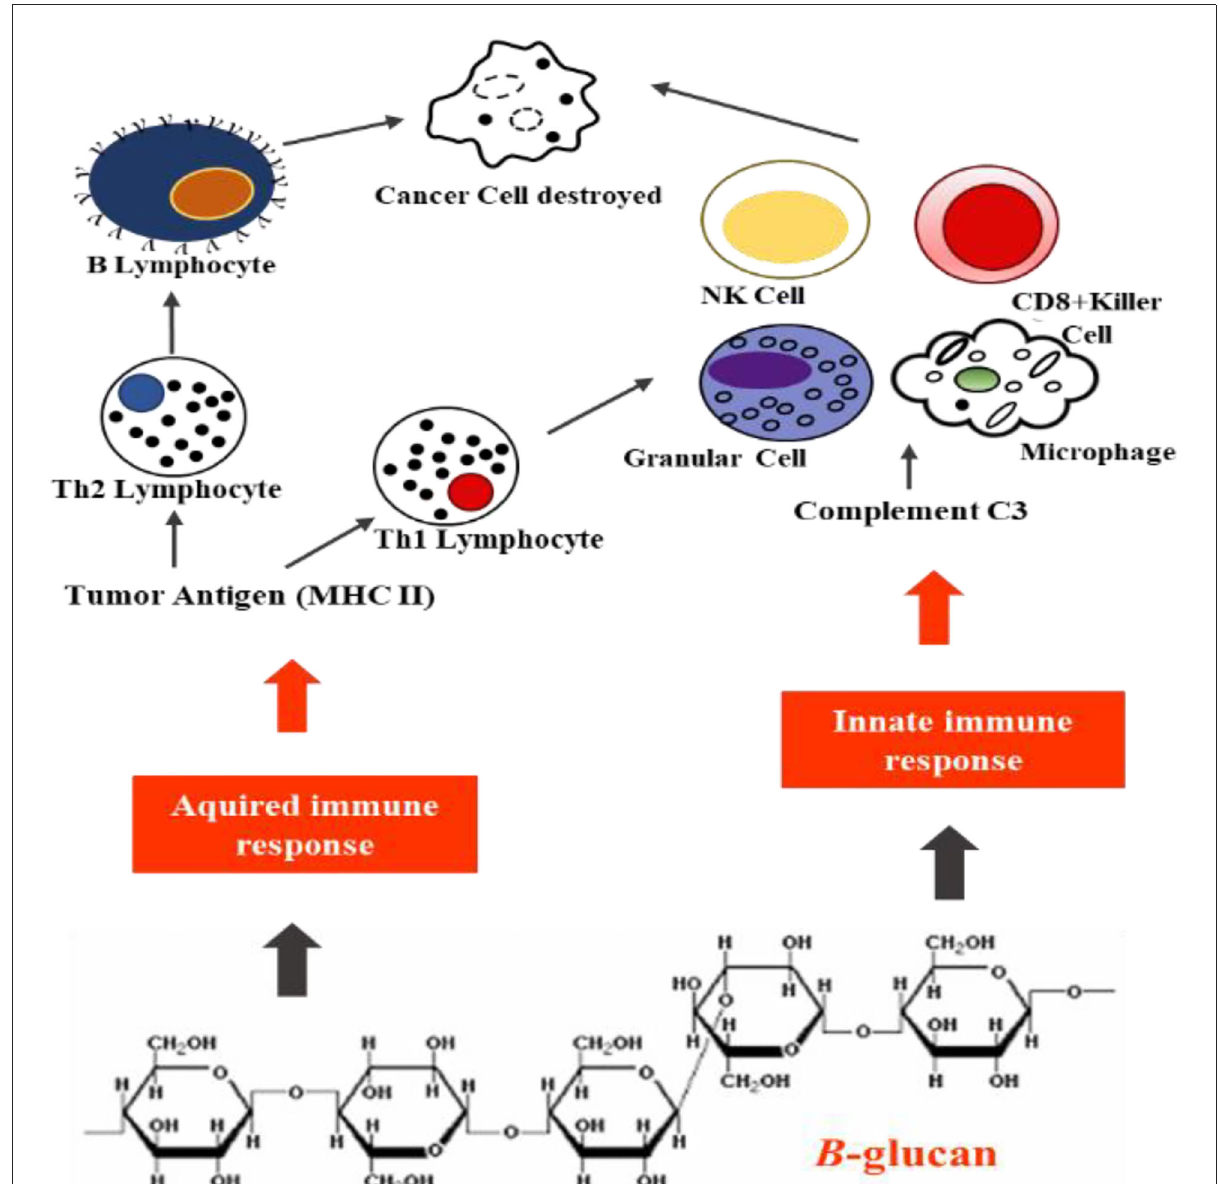
FIGURE5 System of antineoplastic activity of bioactive β -glucan. The complexity and multi-step cancer cell recognition by the immune system, and the possible therapeutic applications of tumor-specific major histocompatibility complex (MHC-II). Normally, tumor cells do not express MHC-II